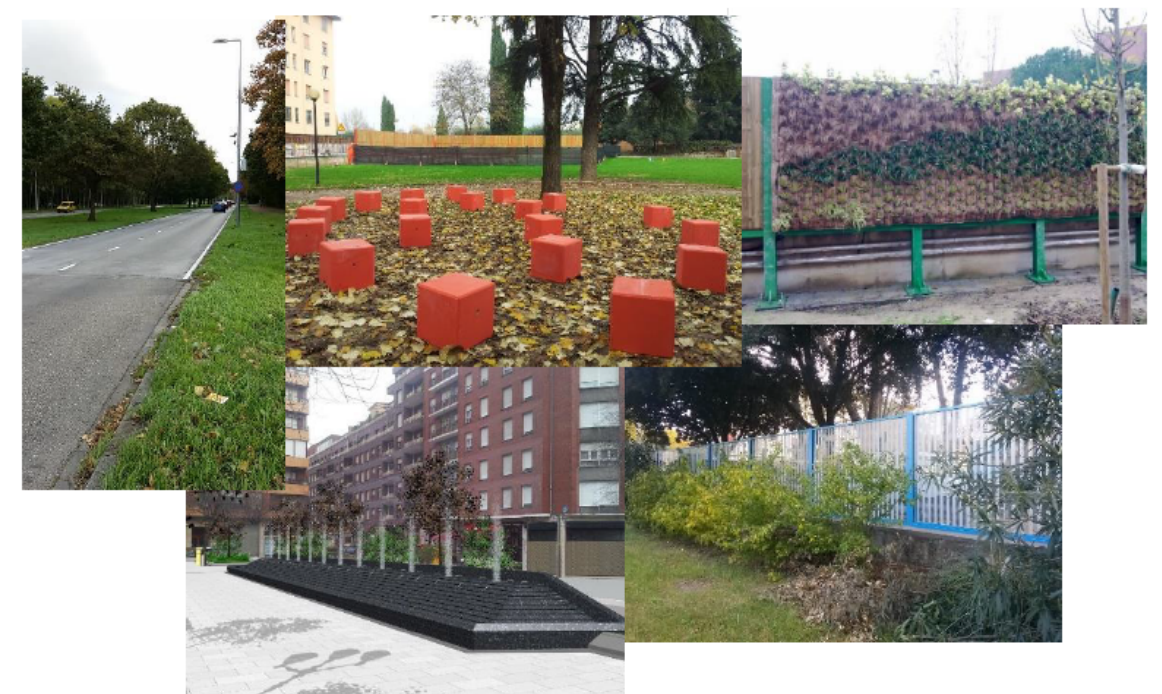
Figure 3: Examples of carried out interventions (low noise paving, noise barriers, seats) in the pilot areas. ing due to the fragmented state of existent methodologies.